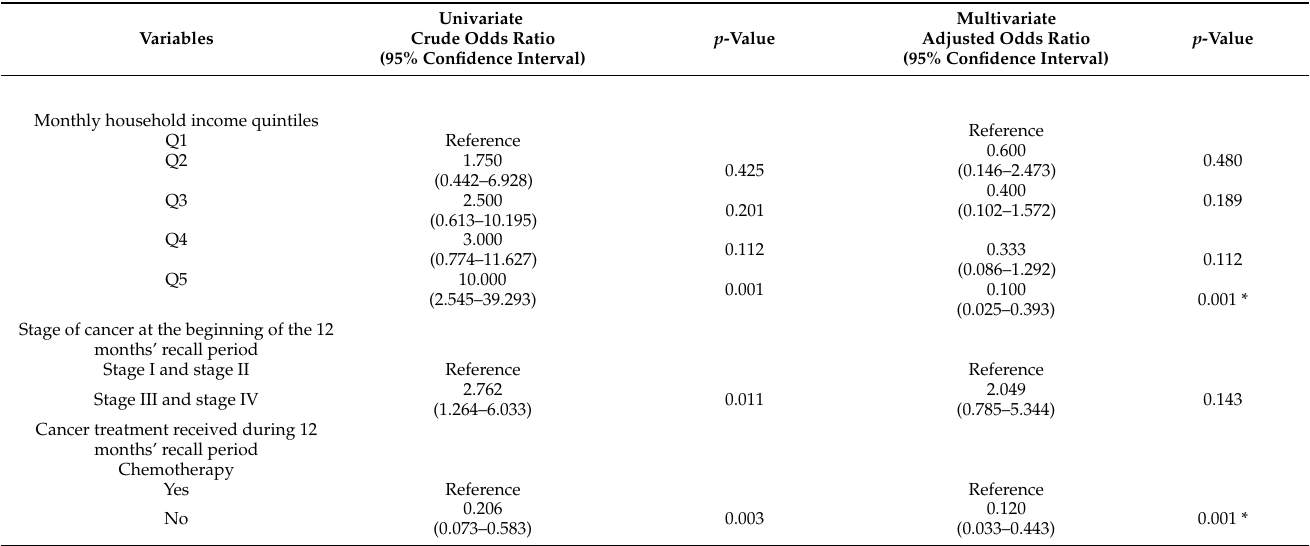
Table 5. Estimated association between variables and catastrophic health expenditure using univari- ate and multivariate regression analysis according to income quintiles ( N =